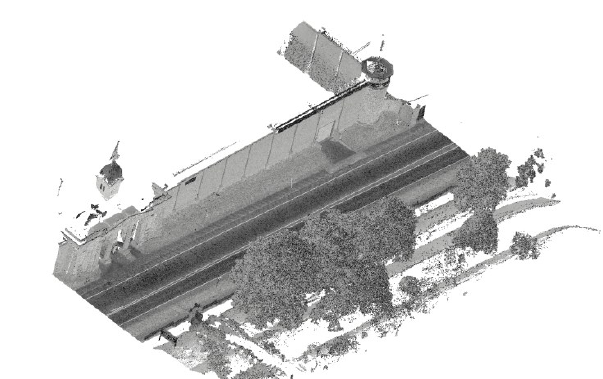
Figure 2. Point clouds acquired by RIEGL VMX-450.